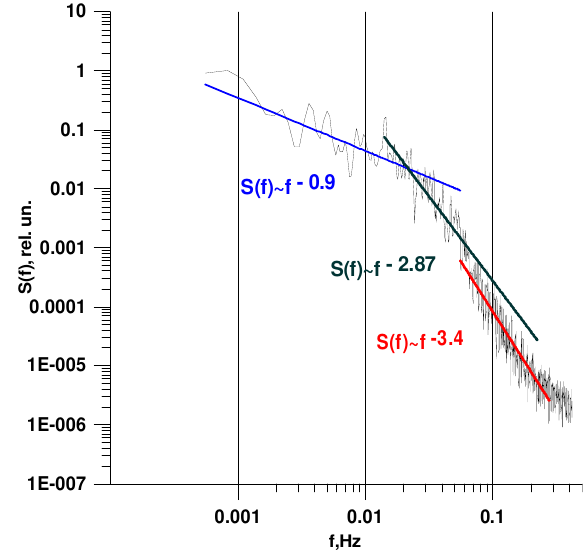
0.001 Fig. 6. EF pulsation spectrum for stable conditions (early morning period 00:30–01:30UT of 30